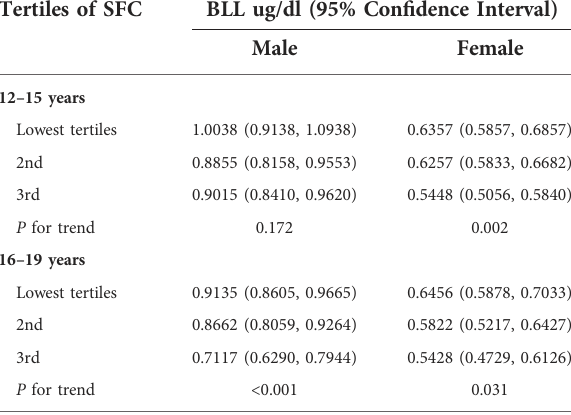
TABLE 4 Blood lead levels by tertiles of serum folate concentration, strati fifi ed by age and sex.